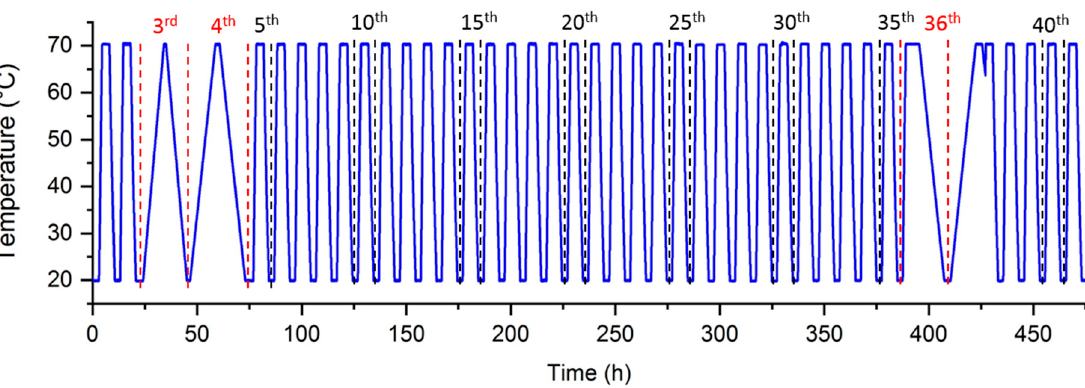
Figure 13. Evolution of temperature throughout aging cycles.